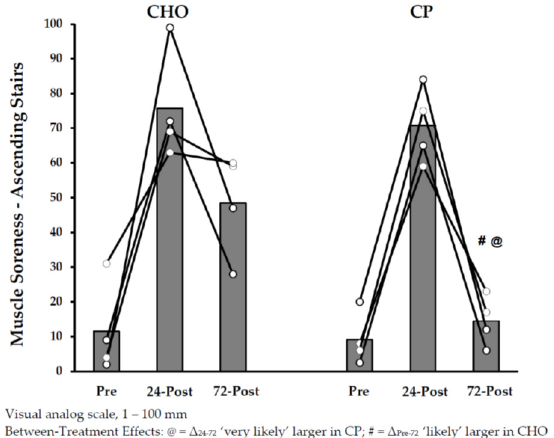
Figure 4. Muscle Soreness Ratings (Ascending Stairs) with Protein Supplementation Post ‐ Exercise.